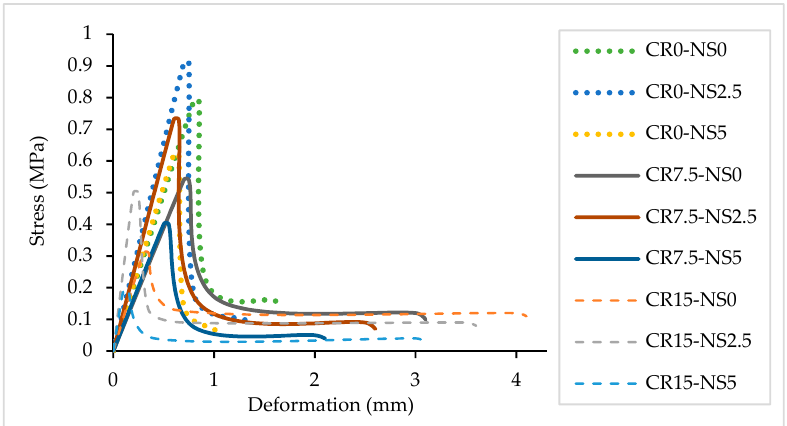
Figure 5. Deformation of NS-CRM samples at 28 days.